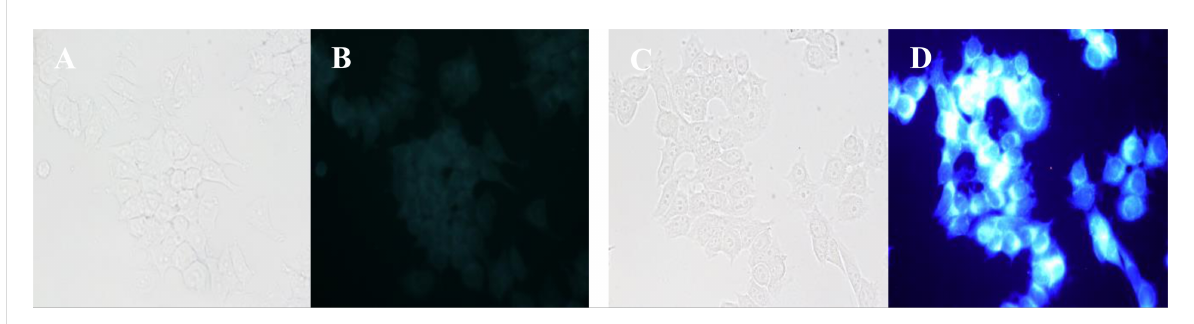
Figure 8: Labeled MCF-7 cells using compound 9 (C,D) and unlabeled MCF-7 cells (A,B) in microscope (2 h, c ( 9 ) = 100 μ M, B and D passed sepa- rately through filter (365 ± 20